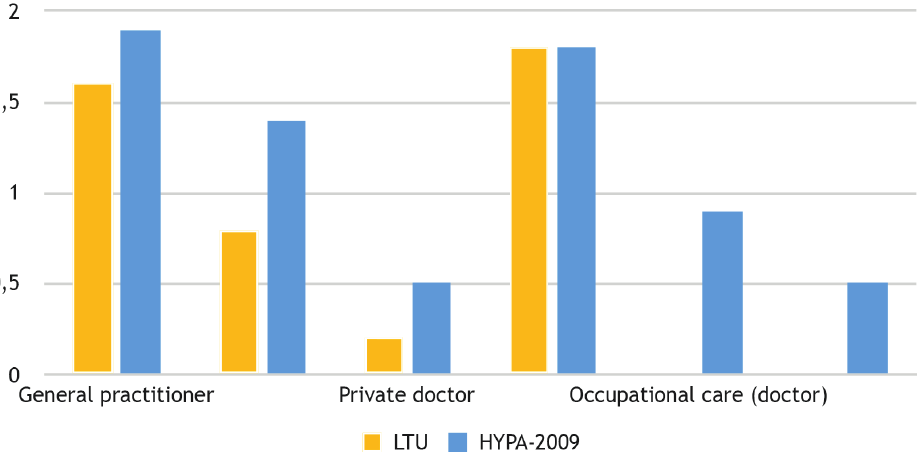
Figure 2. Number of visits to outpatient health services among the long-term unemployed (LTU) and the general population in employment